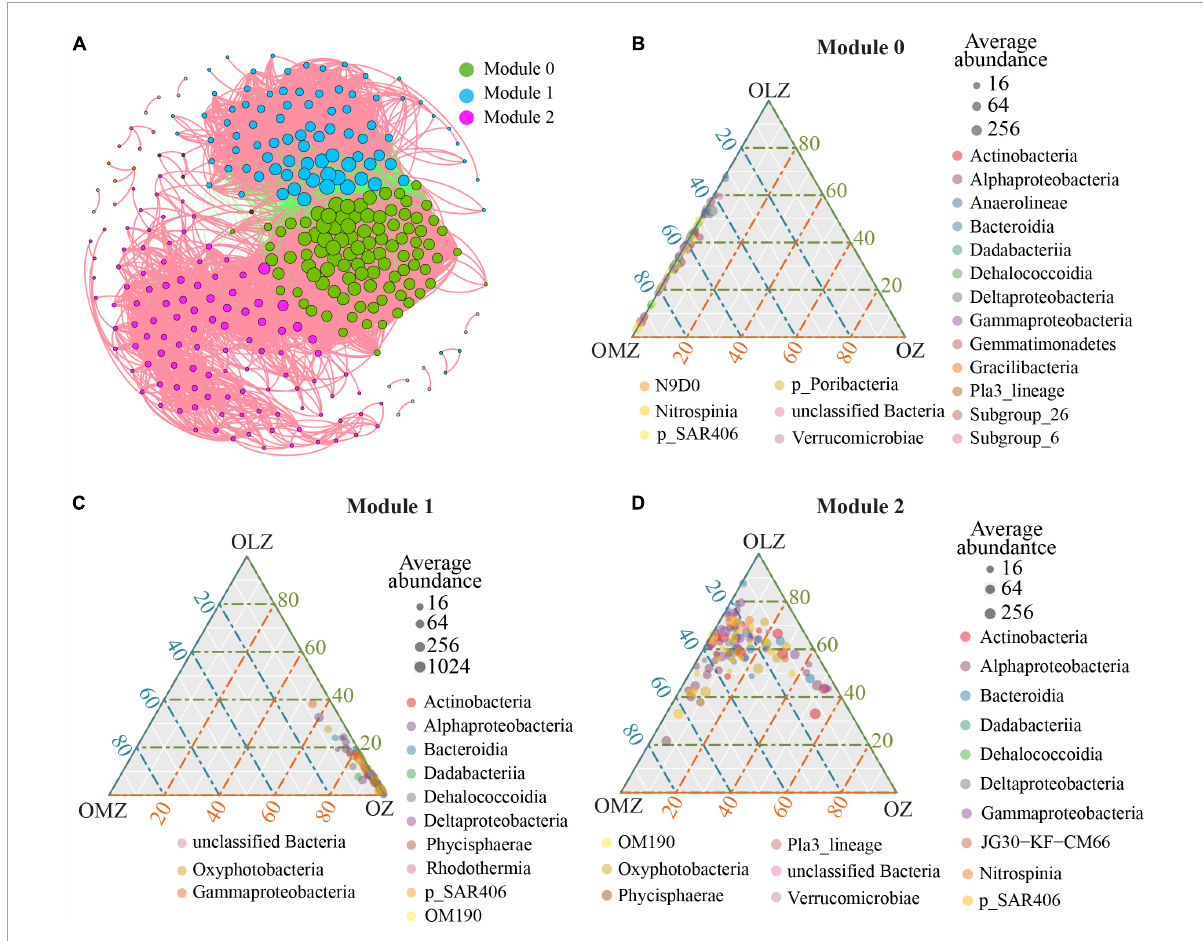
FIGURE6 Co-occurrence patterns of microbial populations based on Spearman’s correlation analysis. (A) Co-occurrence network. Network nodes represent OTUs and the size of each node is proportional to the number of its associations (degree). Each node is colored in a module. A connection represents a strong and significant correlation of abundance (| r| > 0.8, p < 0.01). (B) Ternary plot showing the distribution of OTUs from module 0 at the class level. (C) Ternary plot showing the distribution of OTUs from module 1 at the class level. (D) Ternary plot showing the distribution of OTUs from module 2 at the class level. The gray dots indicate the average abundant of taxa.